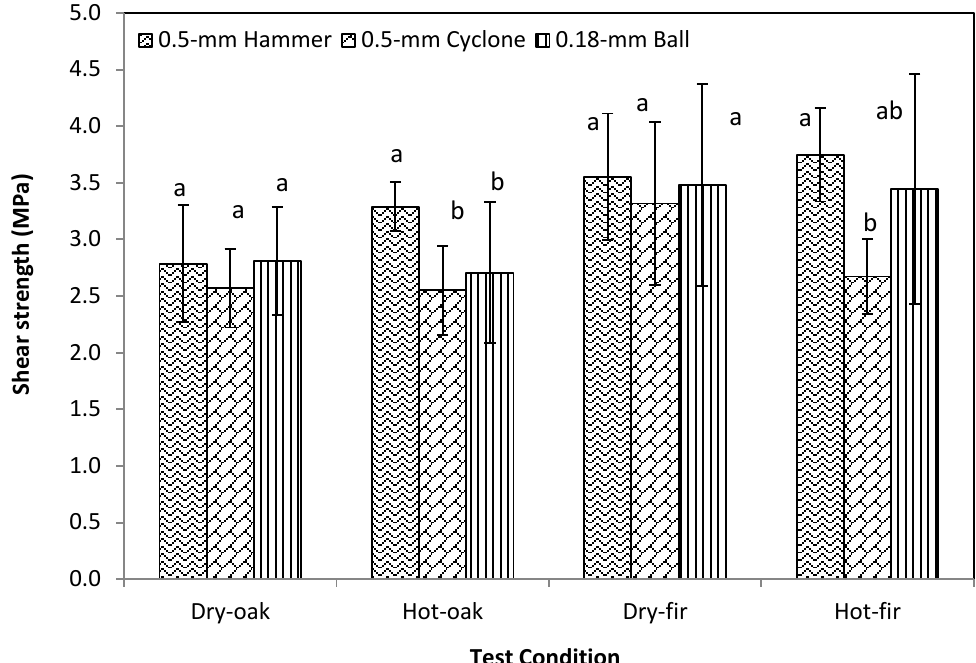
Figure 4. The dry and hot shear strength of white oak and Douglas fir veneer pairs bonded by three WCSM products. Data are presented as average ± SD ( n = 10 but 5 for Dry-fir samples). Different letters in the same type of strength indicate the statistically significant difference between the values at p ≤ 0.05.